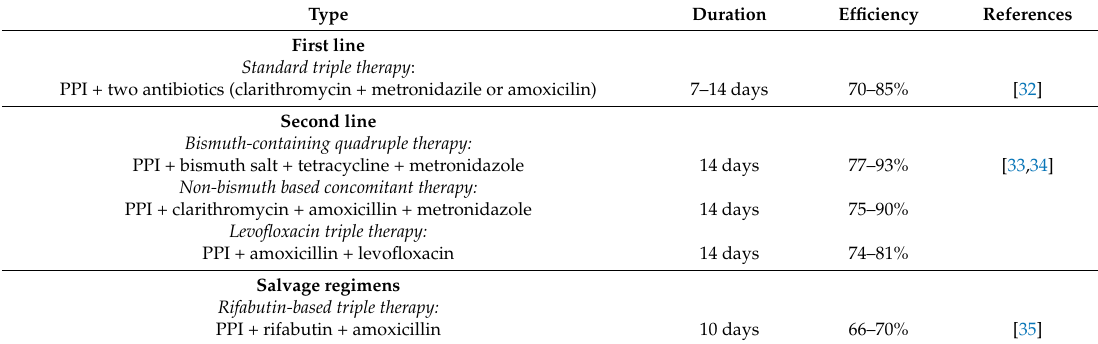
Table 2. Types and efficiency of Helicobacter pylori (H. pylori) eradication treatment